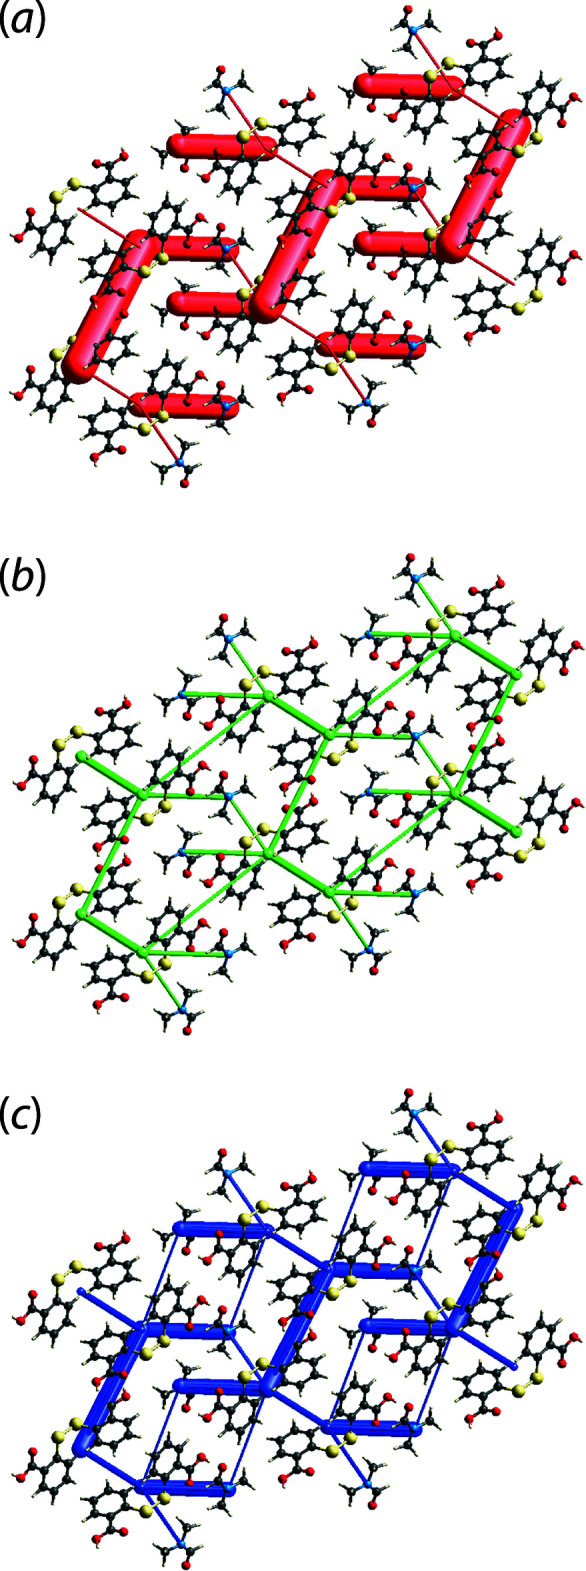
The energy frameworks for (I) viewed along the a axis, showing the (a) electrostatic force, (b) dispersion force and (c) total energy diagram. The cylindrical radius is proportional to the relative strength of the corresponding energies and they were adjusted to the same scale factor of 100 with a cut-off value of 8 kJ mol−1 within a 2 × 2 × 2 unit cells.